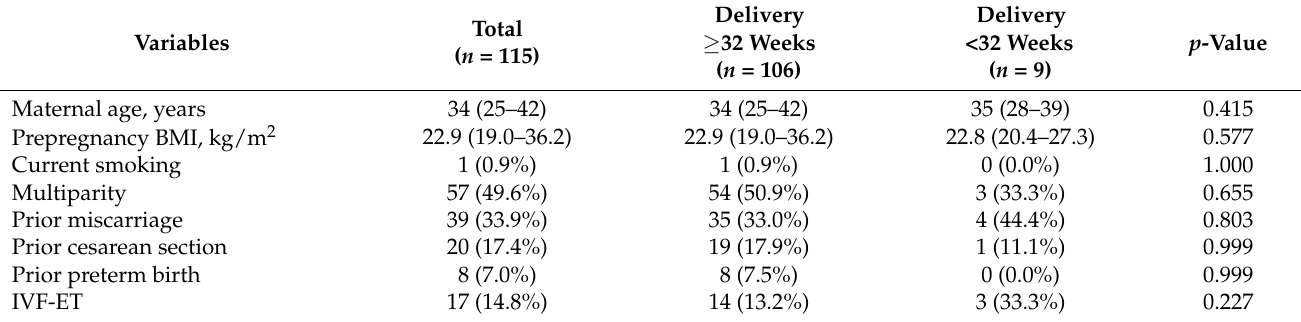
Table 1. Baseline characteristics, clinical findings, and pregnancy outcomes of the study